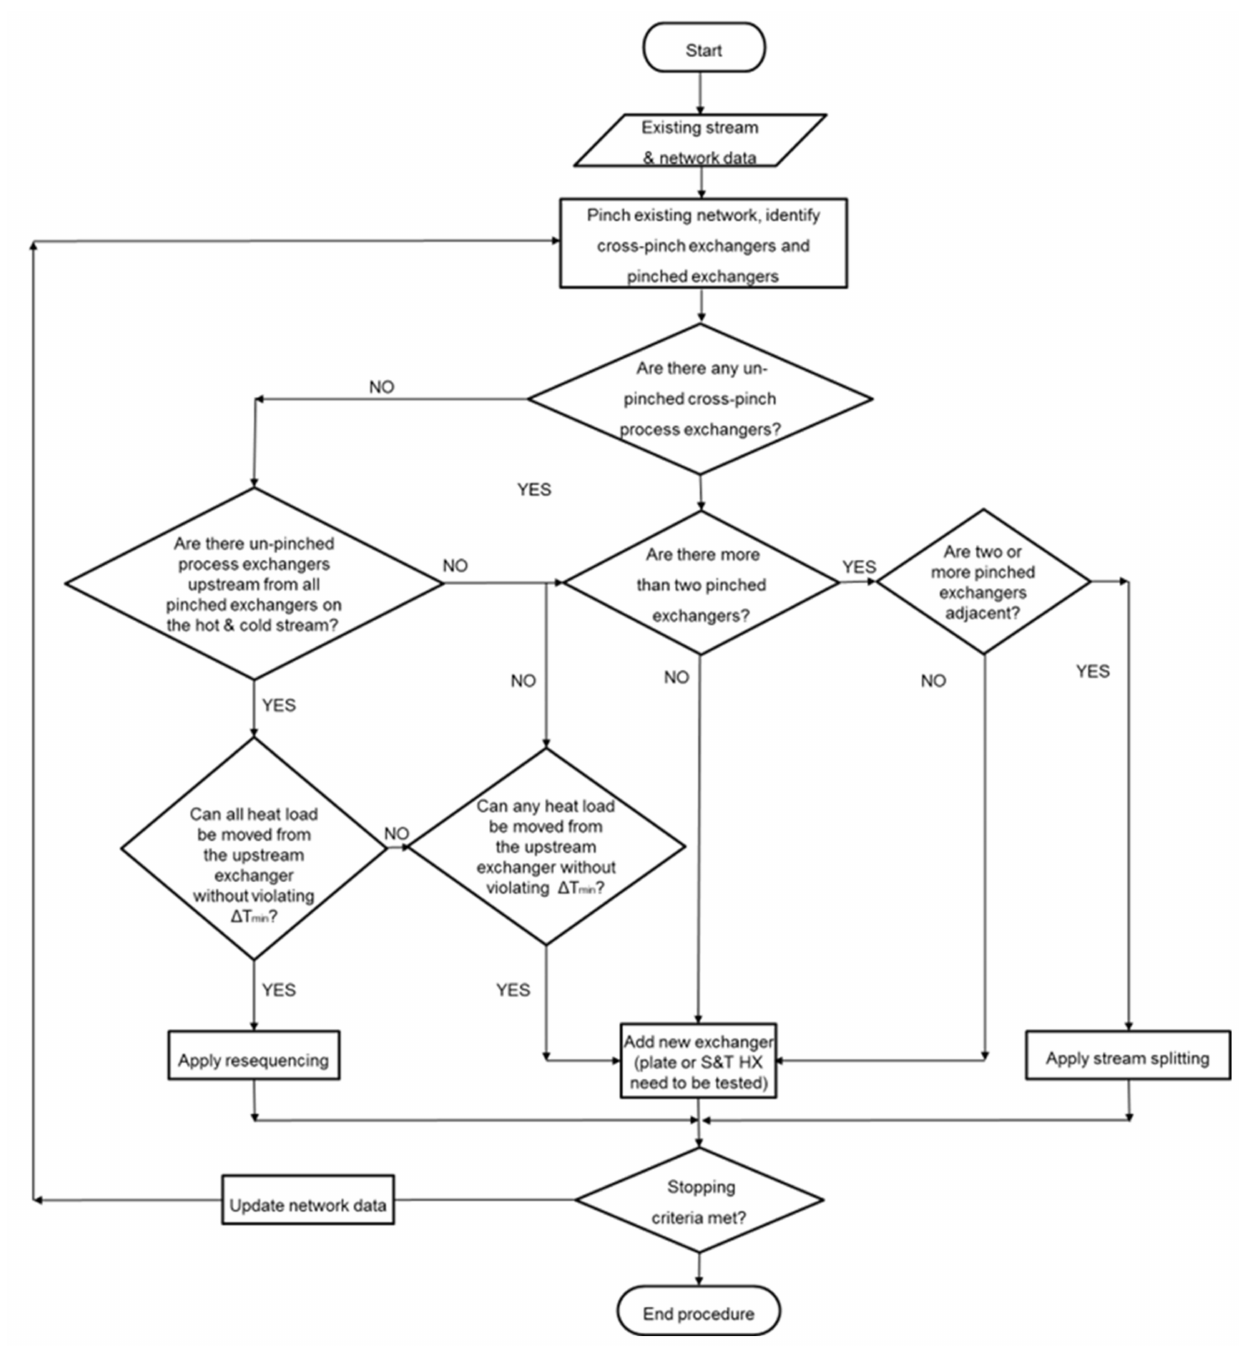
Figure 6. Step-by-step algorithm for